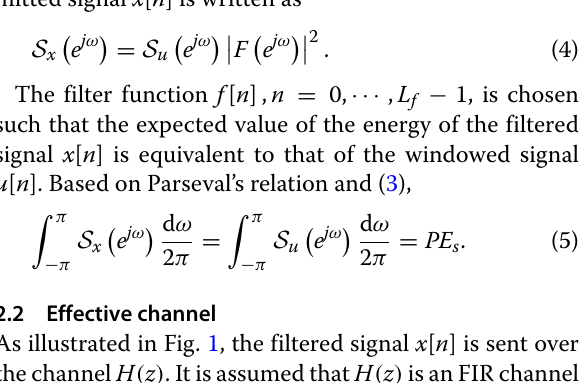
filtering-based waveform is not considered here in order to scale down the complexity of the receiver.